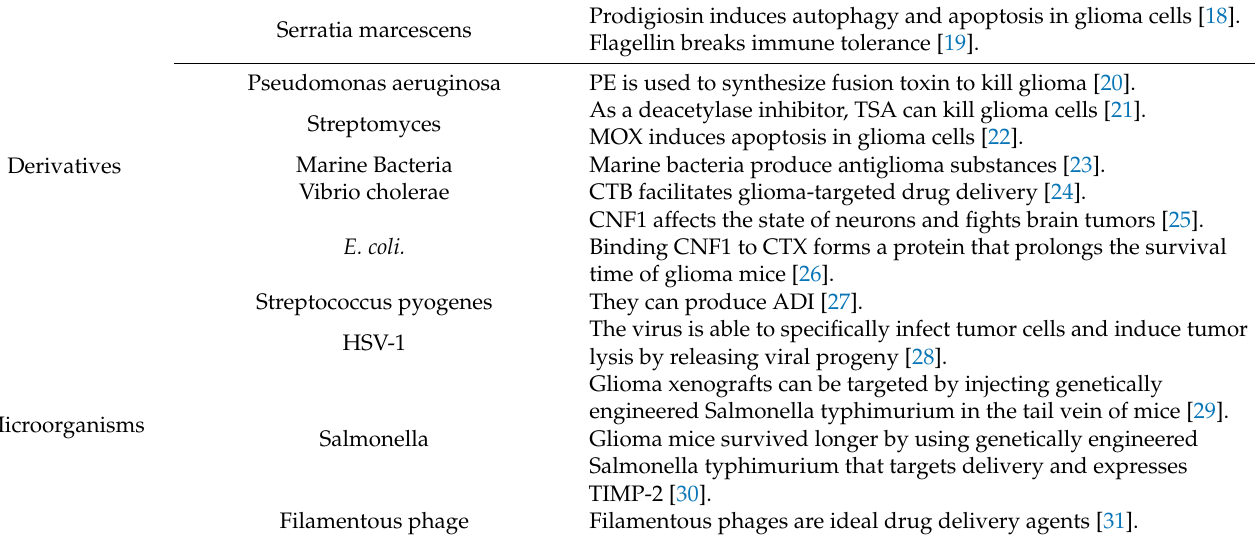
Table 1. Exogenous microorganisms and their derivatives for glioma